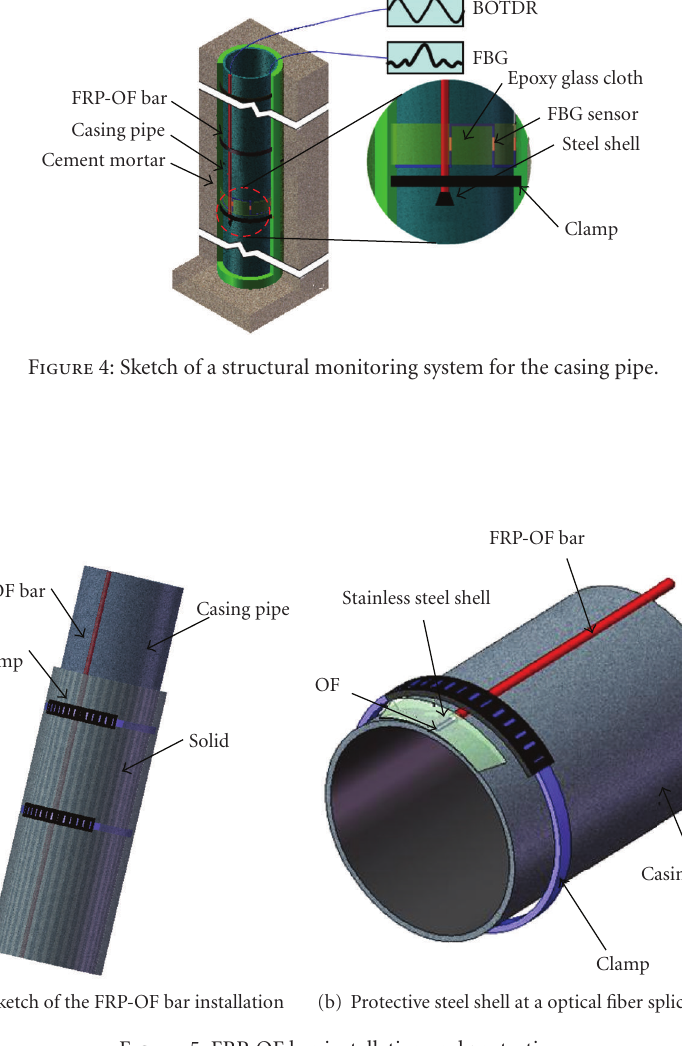
Figure 5: FRP-OF bar installation and protection.